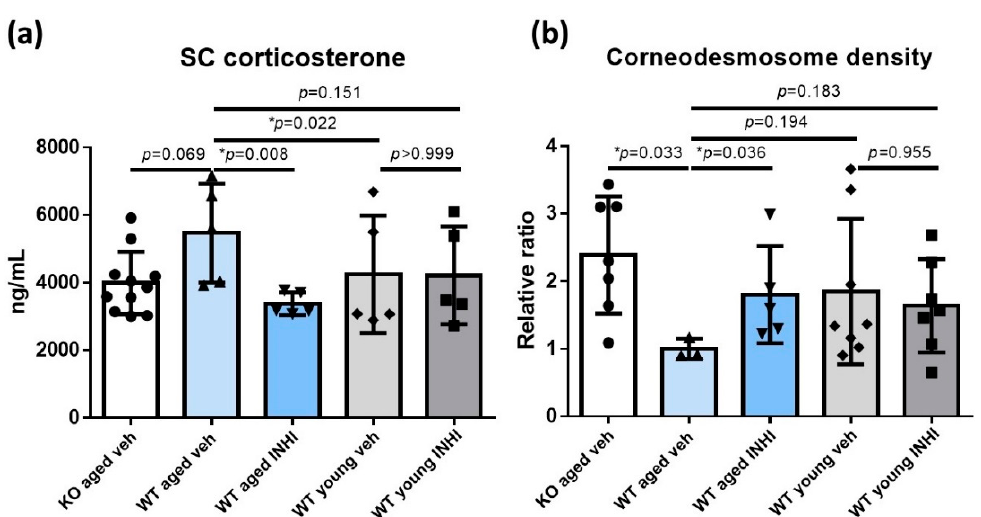
Figure 5. Stratum corneum (SC) corticosterone and corneodesmosome (CD) density in HSD11B1 knock-out (KO) and wild type (WT) mice. ( a ) The SC corticosterone level was the highest in the aged WT mice. Both the HSD11B1 KO and treatment with the 11 β -HSD1 inhibitor (INHI) decreased the SC corticosterone level in the aged mice. ( b ) The CD density was the highest in the aged KO mice. The aged WT mice showed lower CD density than the young WT mice. INHI treatment increased the CD density in the aged WT mice. The data are presented as the means ± SD. * statistically significant ( p < 0.05); veh, vehicle.